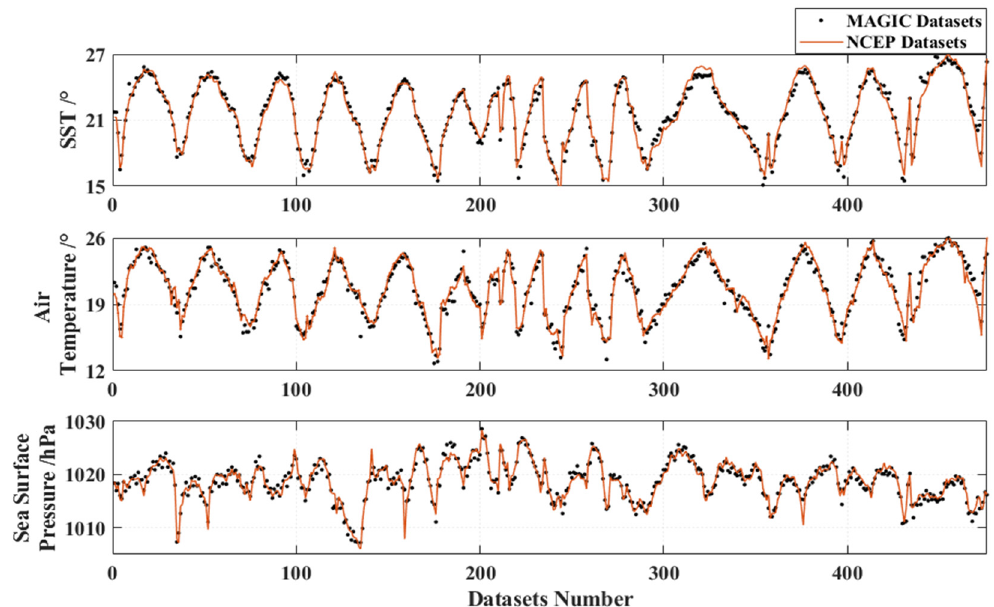
Figure 2. Comparison between MAGIC and NCAR datasets.